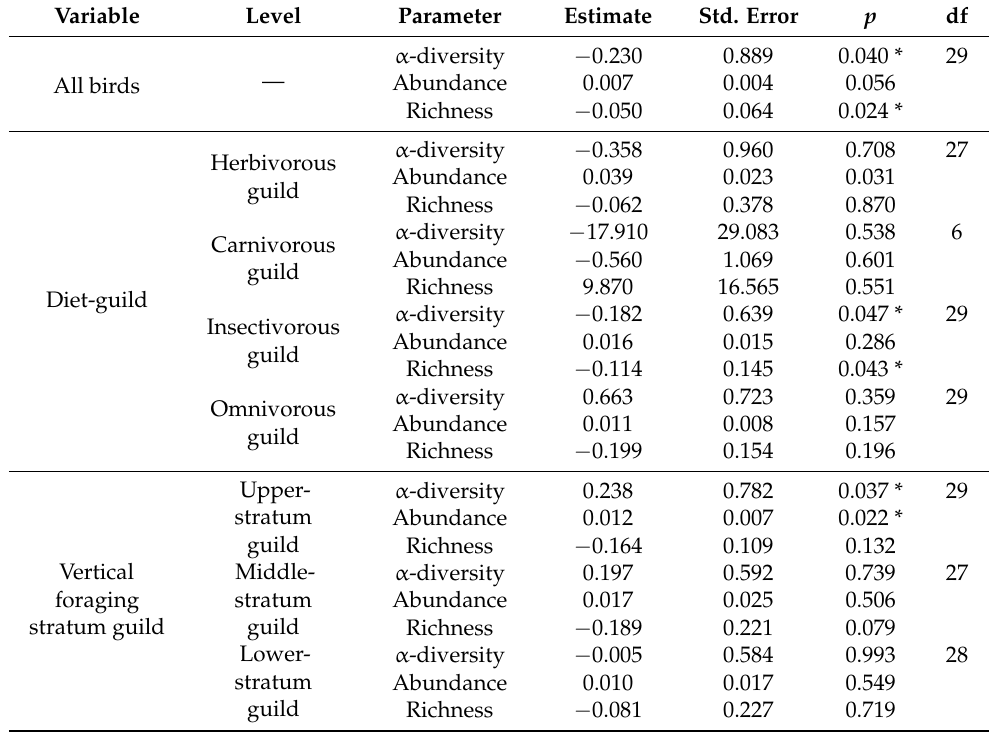
Figure 2. Comparison of individual-based interpolation (rarefaction) and extrapolation of species diversity in different urbanization types of mountain parks. When the curve tends to be flat, the observed number of species is gradually reasonable, and more individuals will only produce fewer new species. Table 2. Results of GLM test for the effect of disturbance on within-diet and foraging-stratum guild a-diversities across the three disturbance levels (* = p < 0.05).